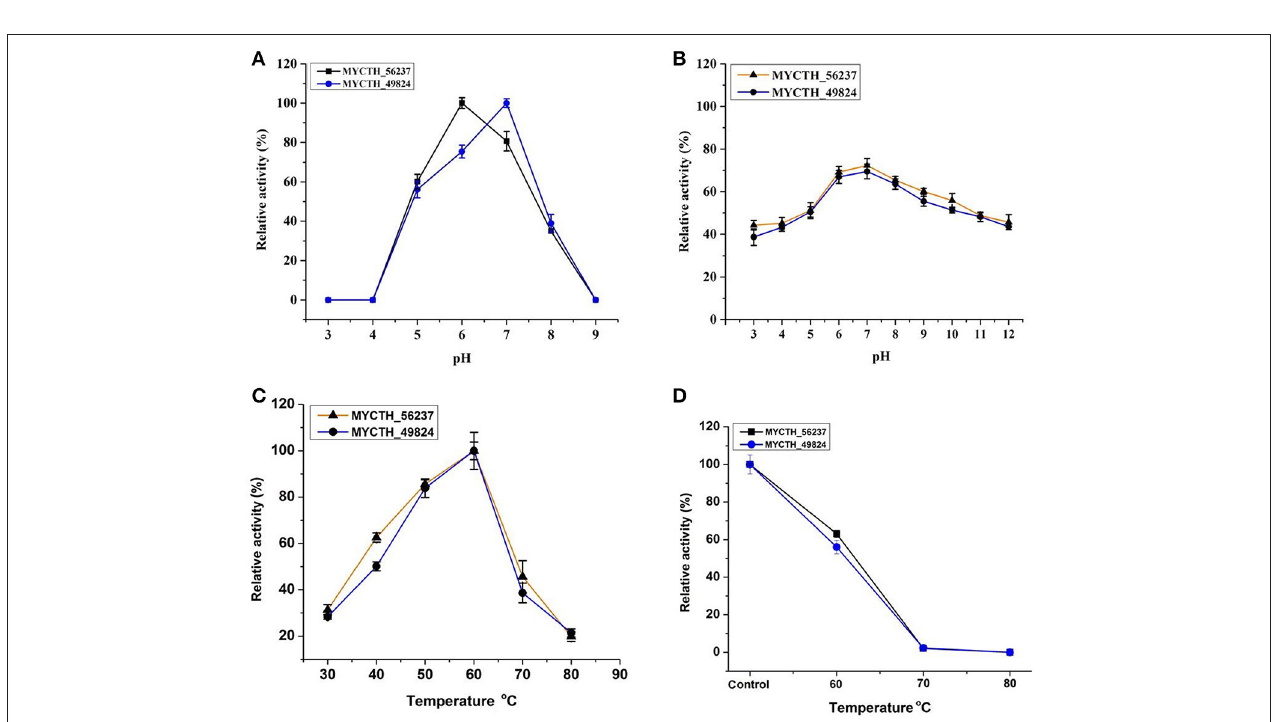
FIGURE 3 | Enzymatic properties of the purified recombinant MYCTH_56237 and MYCTH_49824 in P. pastoris using RBB-xylan as the substrate. (A) Effect of pH on enzyme activity. (B) pH stability of MYCTH_56237 and MYCTH_49824. (C) Effect of temperature on enzyme activity. (D) Thermostability of MYCTH_56237 and MYCTH_49824 at their optimum